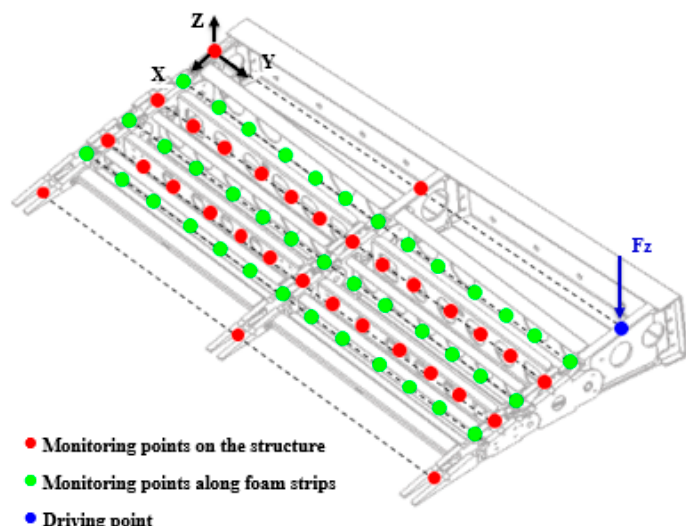
Figure 21. Ground vibration test: acquisition map and driving point.